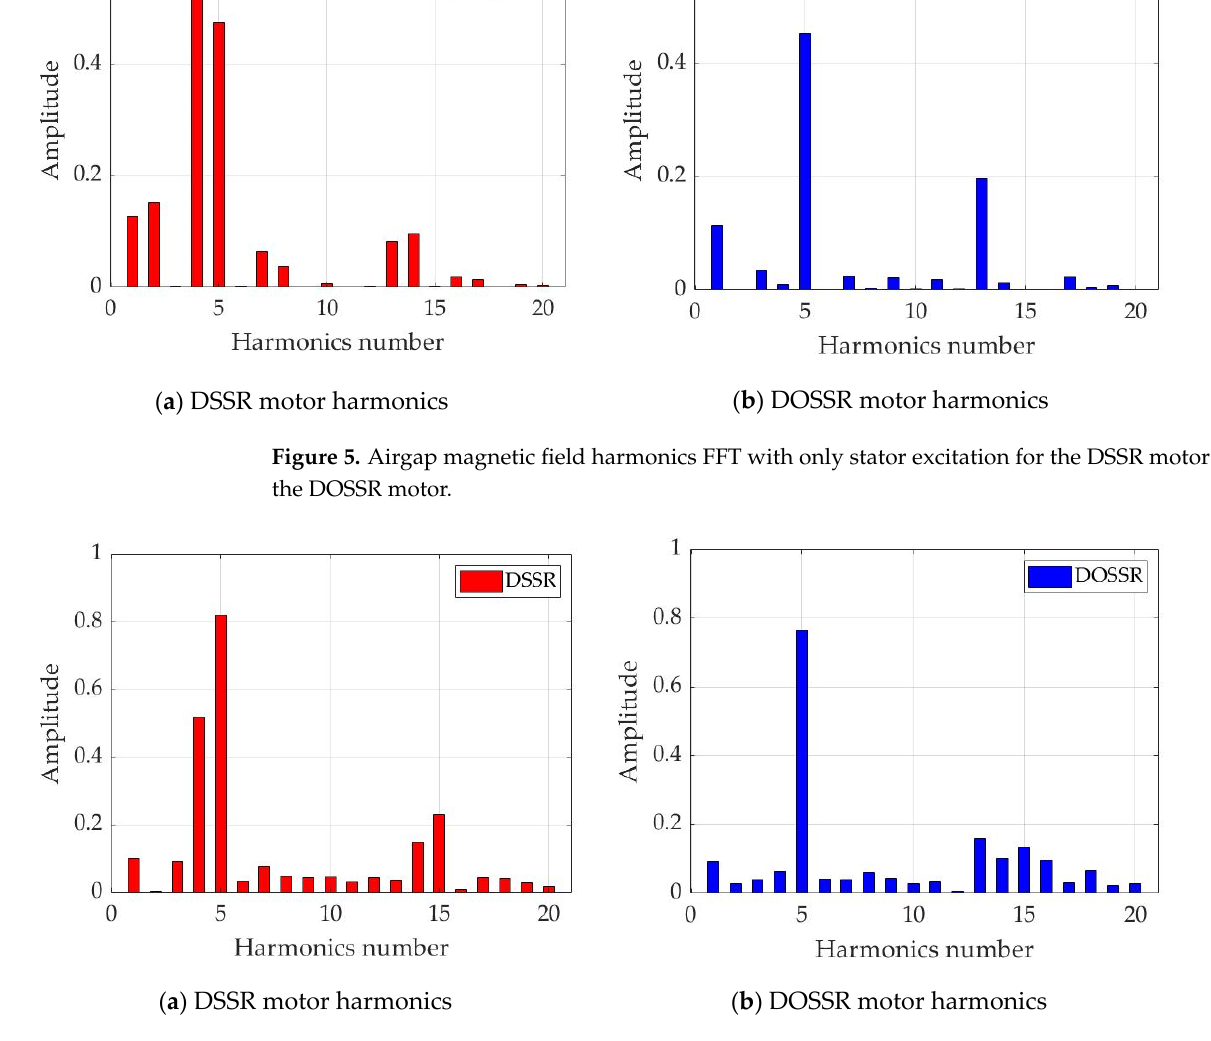
Figure 6. Airgap magnetic field harmonics FFT with stator excitation and rotor PMs for the DSSR motor and the DOSSR motor (100 A rms, 900 rpm).